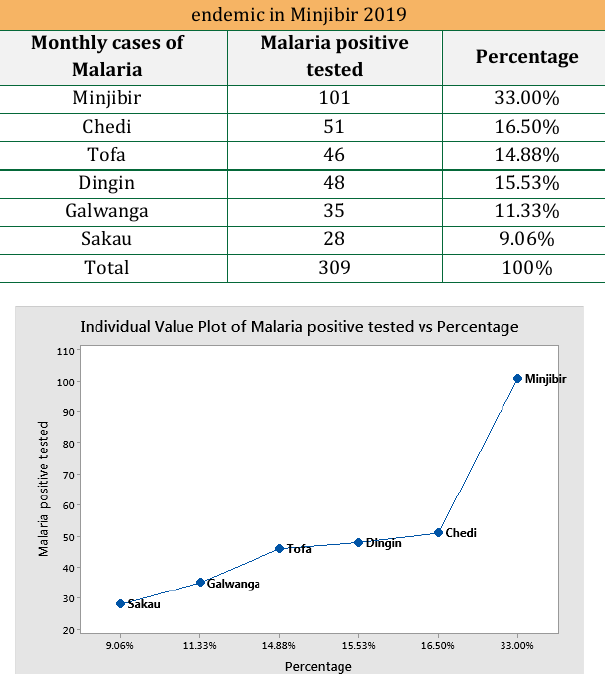
Table 4: Average Monthly analysis of the prevalence of the Malaria